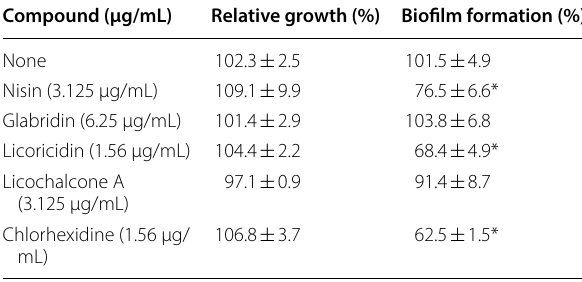
*Significant reduction ( p < 0.01) compared to control cultures without compounds